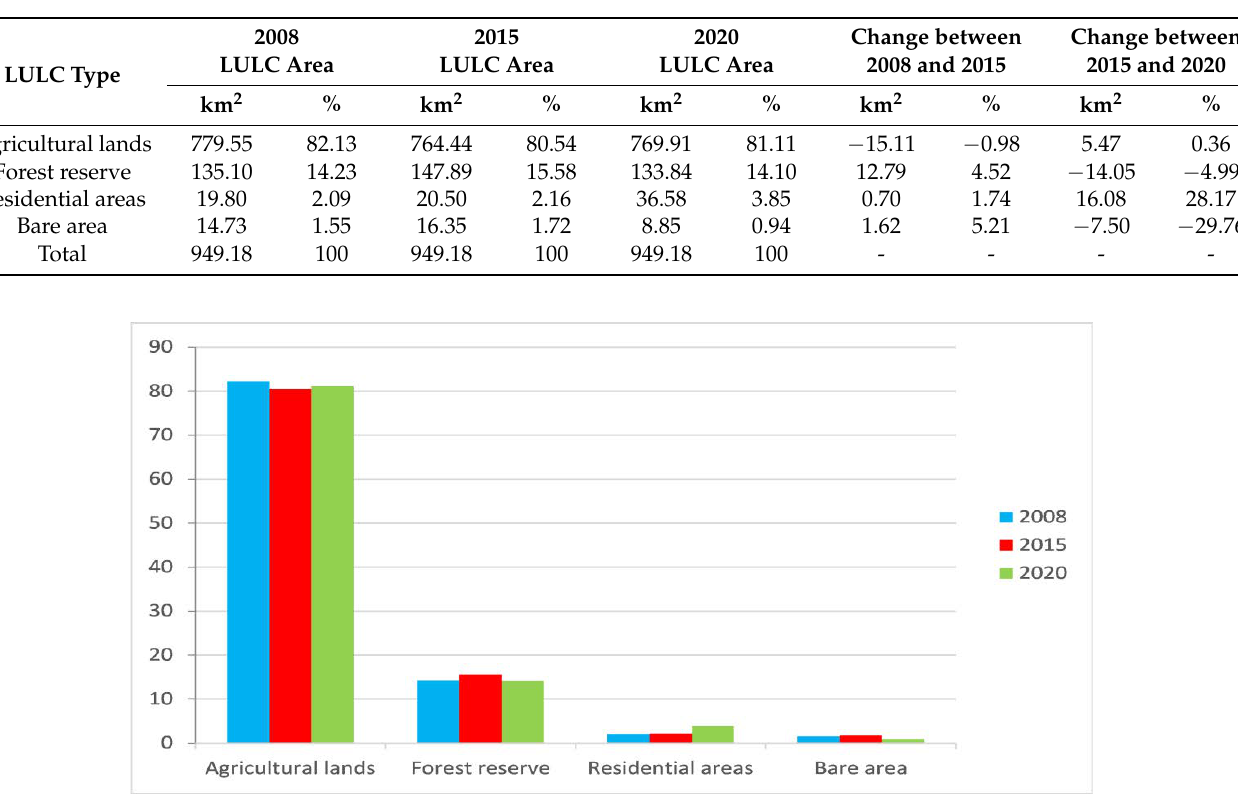
Figure 6. The land covers categories changes during the 2008 to 2020 periods (%).